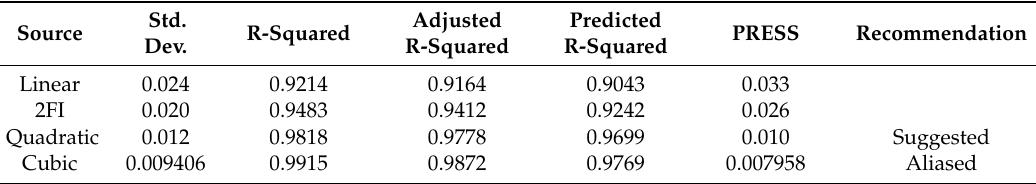
Table 6. Statistical Summary of Coe ffi cient of Friction